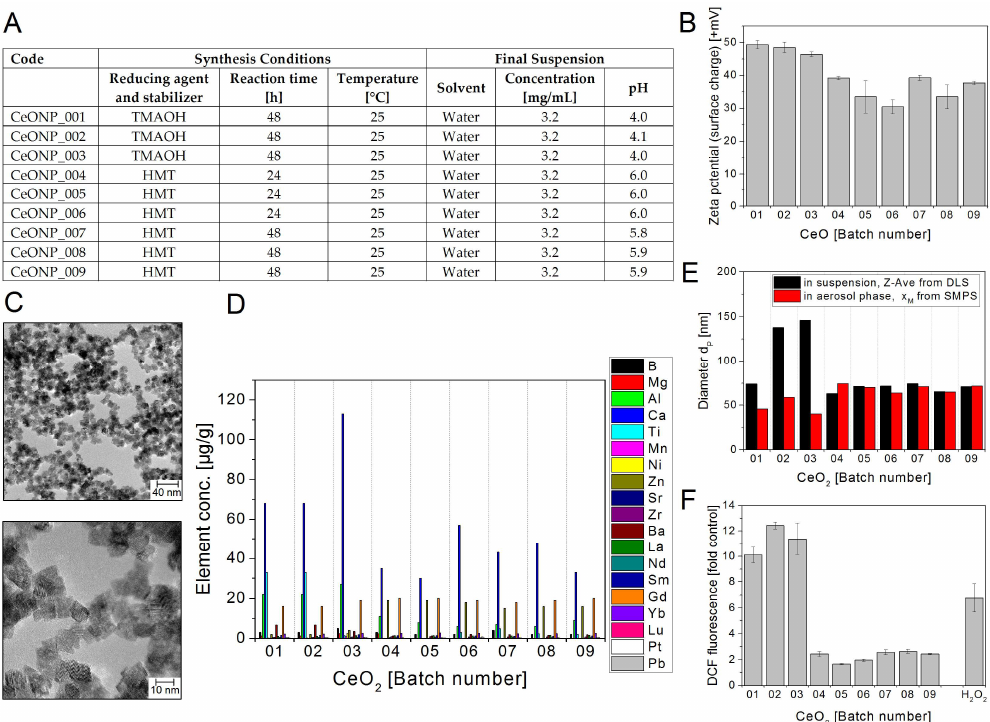
Figure 6. Cerium dioxide NM batches CeO 2 NP01–09 ( A ) Production parameters for sol-gel synthesized CeO 2 nanoparticles. ( B ) Zeta potential representing the surface charge in +mV at pH 3.8 to 6.1. ( C ) Representative TEM images of CeONP_008. ( D ) Selected impurities present in the different CeO 2 NM batches. The mass concentrations of elements above detection limit are shown. The data represent the mean of two assays. ( E ) Particle diameters d P in nm: Z-Average of d P determined in aqueous suspension using DLS (black bars) and modal value x M of the number size distribution in the aerosol phase measured by SMPS (red bars). ( F ) Potential to induce ROS. The test particles were delivered as suspensions of 3.2 mg/mL in water. The graph shows the DCF fluorescence induced by the different batches at 400 µg/mL relative to a sample without NMs (control). 0.3 µM H 2 O 2 was used as positive control. The data represent mean values of 2 independent experiments with three replicates ± s.e.m.